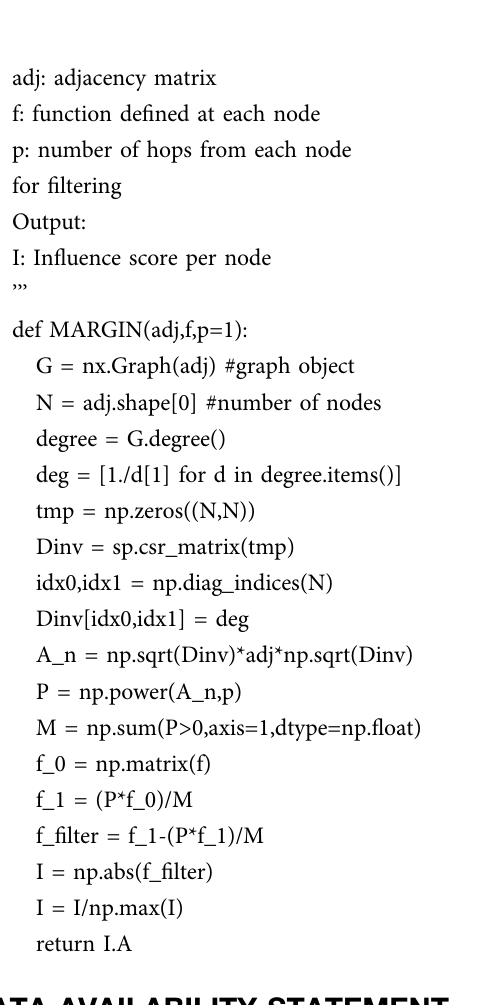
FIGURE 8 | MARGIN based sampling for graph signals shows signi fi cant improvement in label propagation performance, even for very small sets of samples.